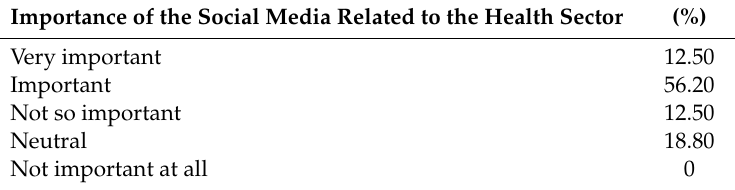
Table 7. Importance of the social media related to the health